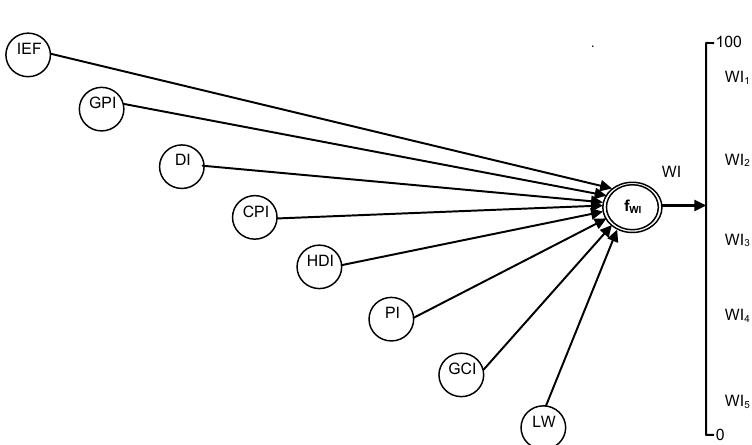
Fig. 9: The structural model of estimation of the level of public welfare of Ukraine